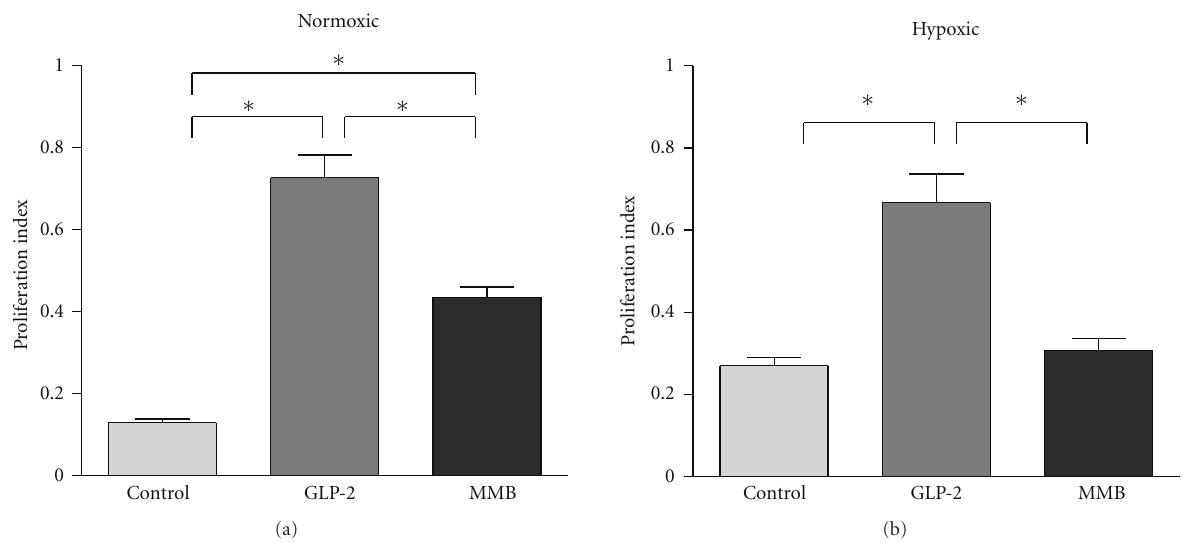
Figure 1: Crypt cell proliferation index. Proliferating cells in the ileal crypts were detected by BrdU immunohistochemical labelling; the index is the number of labelled cells per total cells in each half crypt, averaged from 5 or more crypts per animal, n = 5 or more per group. Data: mean ± SEM, ∗ P < . 05 versus the group indicated, † P < . 05 versus similarly treated group under normoxic conditions. Comparisons by